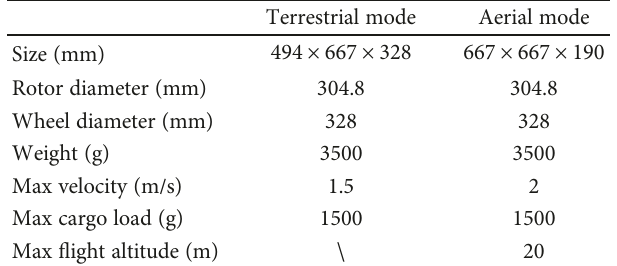
Table 1: Prototype dimensions and performance